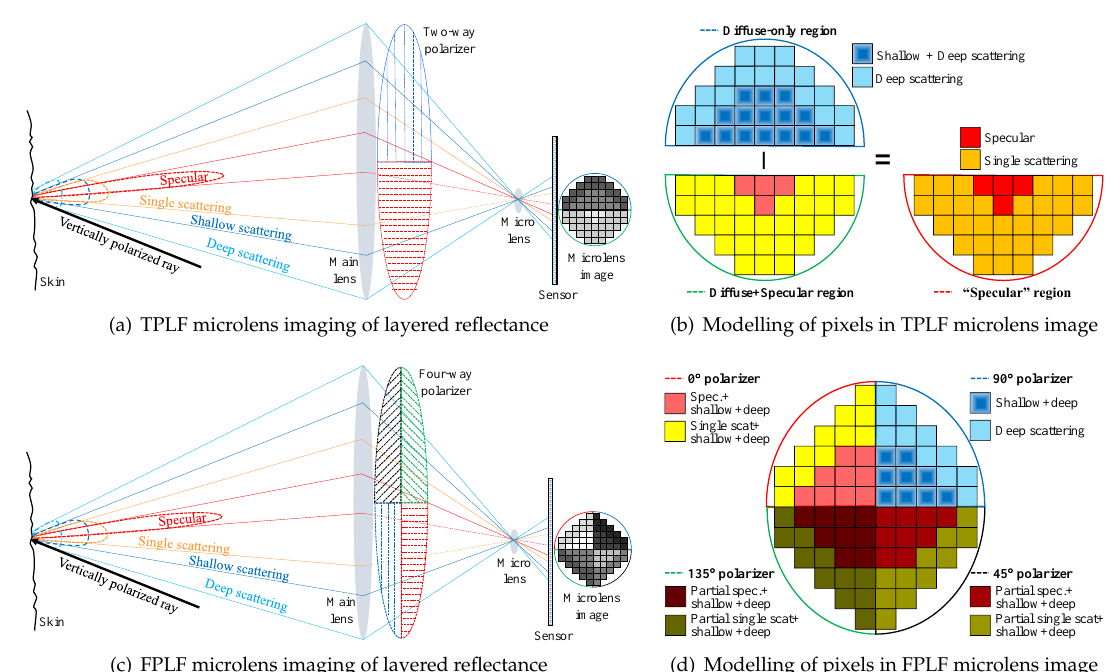
Figure 6. Angular sampling process of the TPLF and FPLF cameras for layered reflectance. ( a , c ) Ray diagram through a two-way ( a ) and a four-way polarizer ( c ). ( b , d ) Modelling of pixel allocation in a microlens image for a TPLF ( b ) (( c ) Eurographics Association 2016) and a FPLF camera ( d [9]).